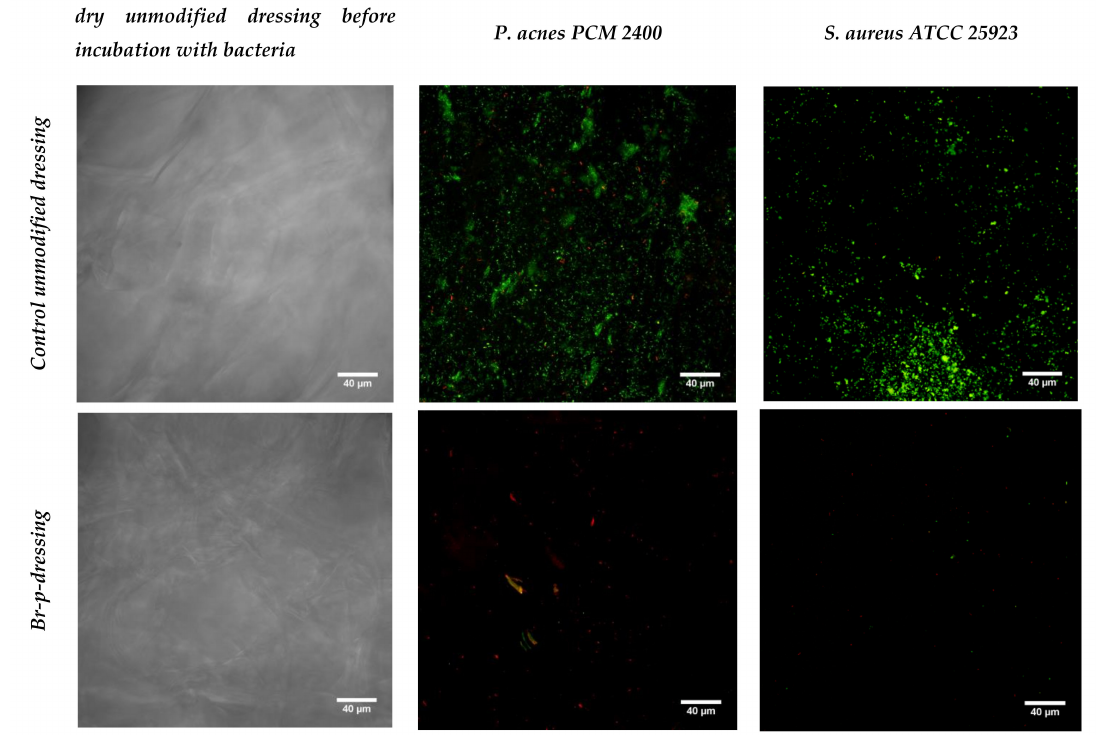
Figure 5. Confocal laser-scanning microscope (CLSM) images showing biofilm formation on